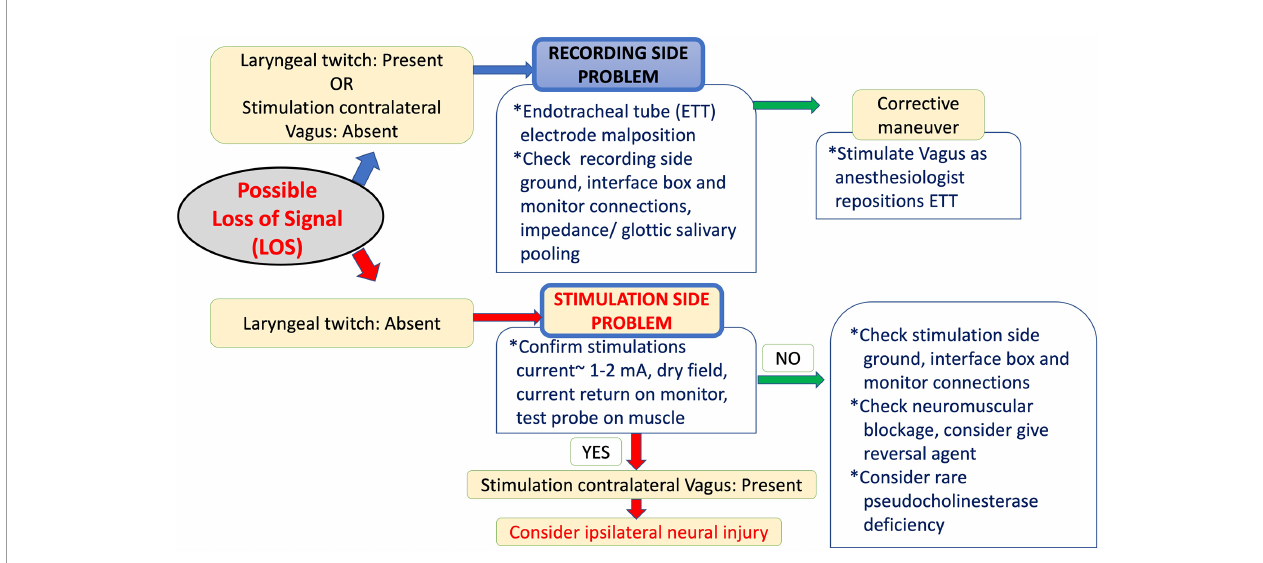
FIGURE 3 | The International Neural Monitoring Study Group (INMSG) recommendation for loss of signal (LOS) evaluation and troubleshooting